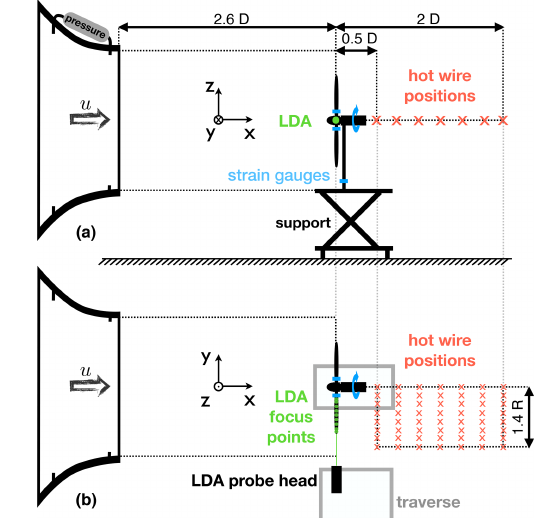
Figure 2. Sketch of the setup in the wind tunnel. View from (a) the side and (b) the top.